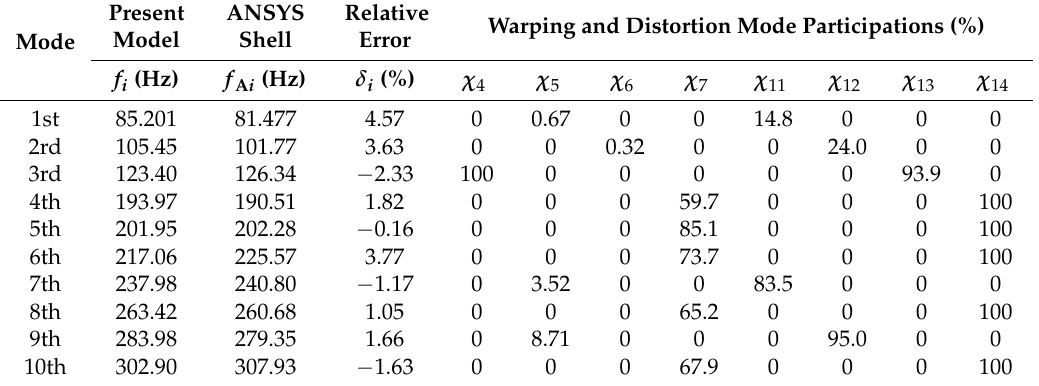
Table 1. Comparison of the first ten natural frequencies of the cantilevered thin-walled structure.